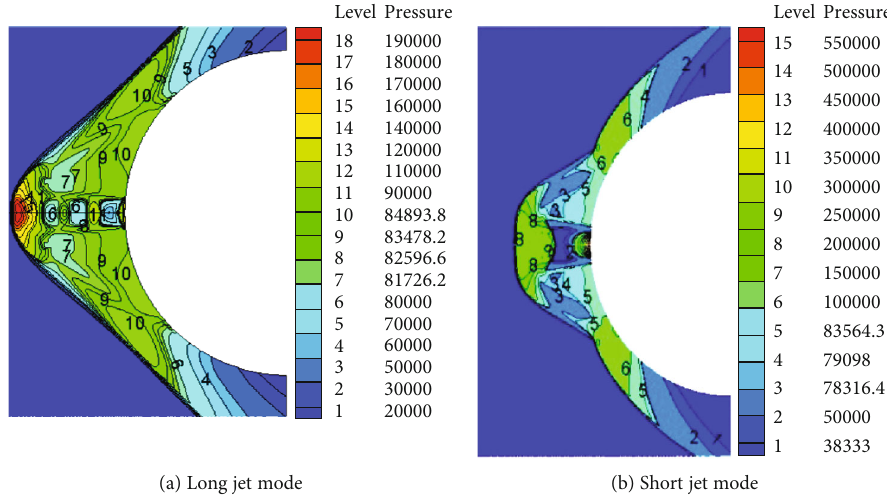
Figure 6: Cloud diagram of pressure distribution under two modal fl